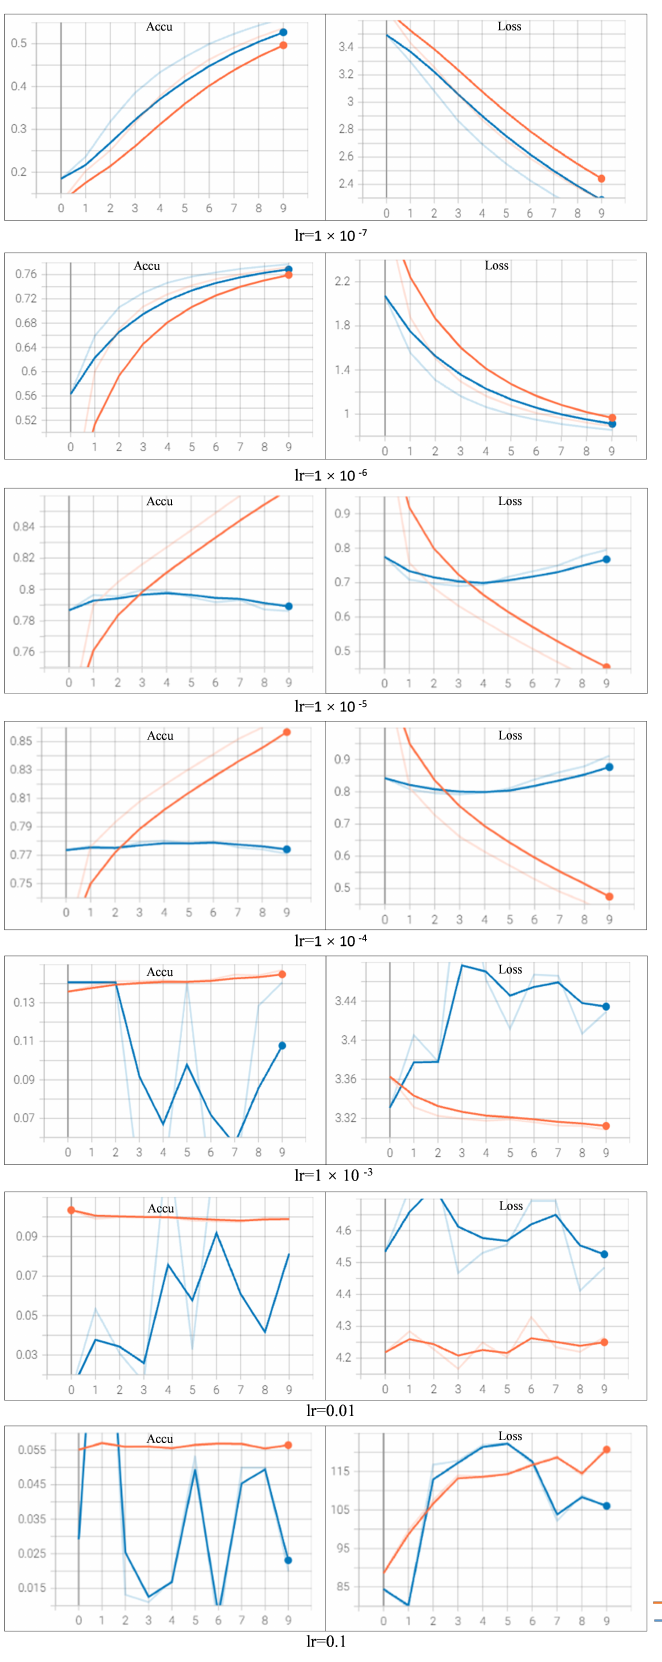
Figure A1. Training and validation performance with different learning rates on Adam optimizer over 10 epochs using the transformers-based